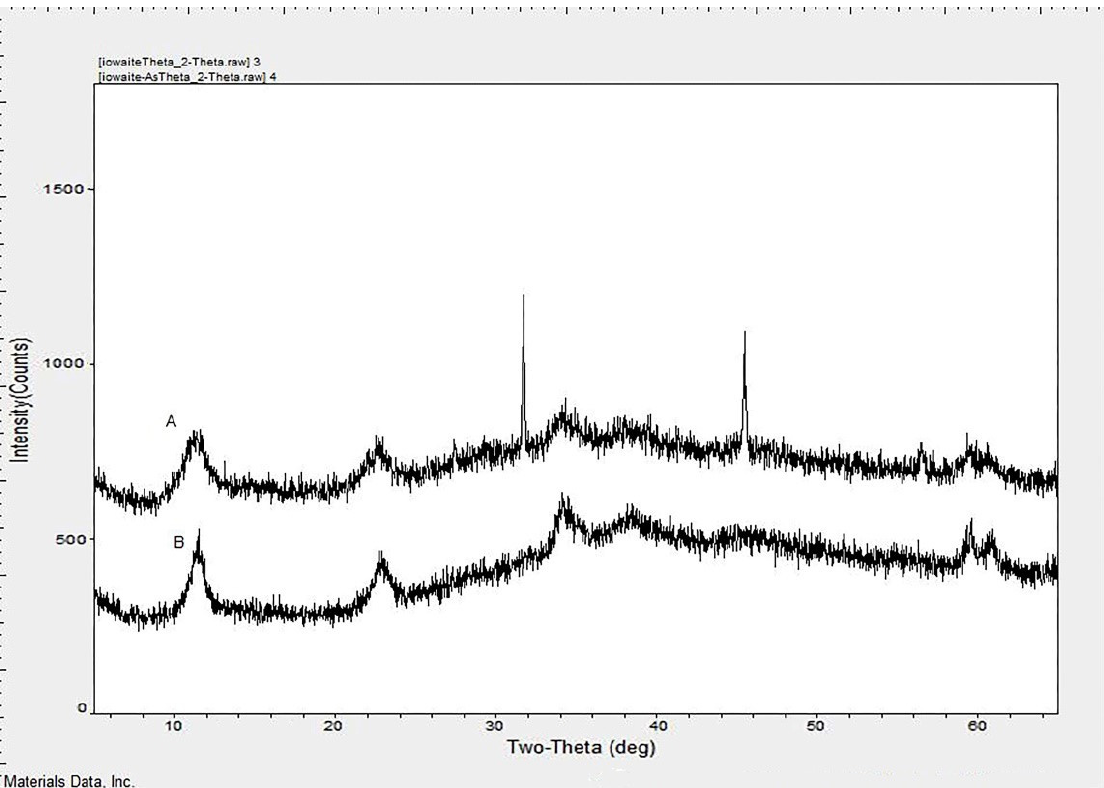
Figure 2. PXRD patterns of iowaite ( A ) and iowaite-As ( B ).